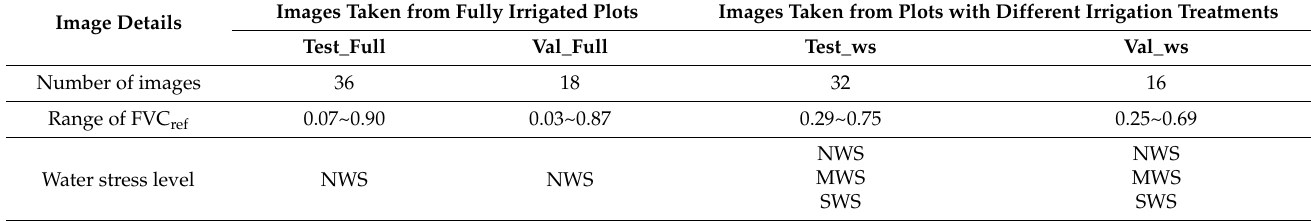
Table 3. A total of 102 RGB images were selected, with 54 images from fully irrigated plots and 48 images from plots under different levels of water stress. FVC ref represents the reference fractional vegetation cover (FVC) of the image. NWS, MWS, and SWS represent no water stress, intermediate water stress, and severe water stress,